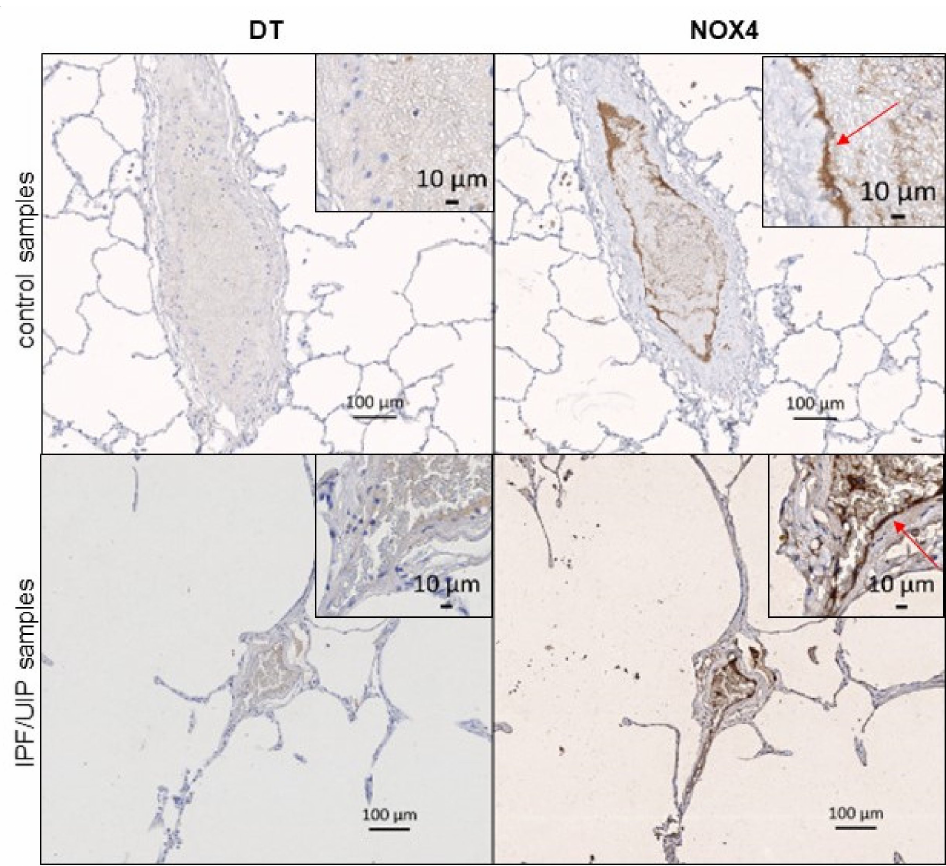
Figure 5. Representative images for DT and NOX4 staining of blood vessel endothelial cells in the control (upper panels) and the IPF/UIP samples (lower panels) from human patients are shown. Inset shows a 10X higher magnification and depicts typical intimal endothelial region of these samples. DT and NOX4 staining are shown in brown. The red arrows indicate the NOX4 endothelial staining. Altogether, DT staining was found in none of our control samples, but was present in SMC, AEC and AECII in all tested IPF patients (Figure 6A). NOX4 staining was present in EC in both control and IPF samples, while AECII and SMC cells were mainly stained only in IPF patients (Figure 6B). Note that both antibodies stained macrophages in all samples (Figure